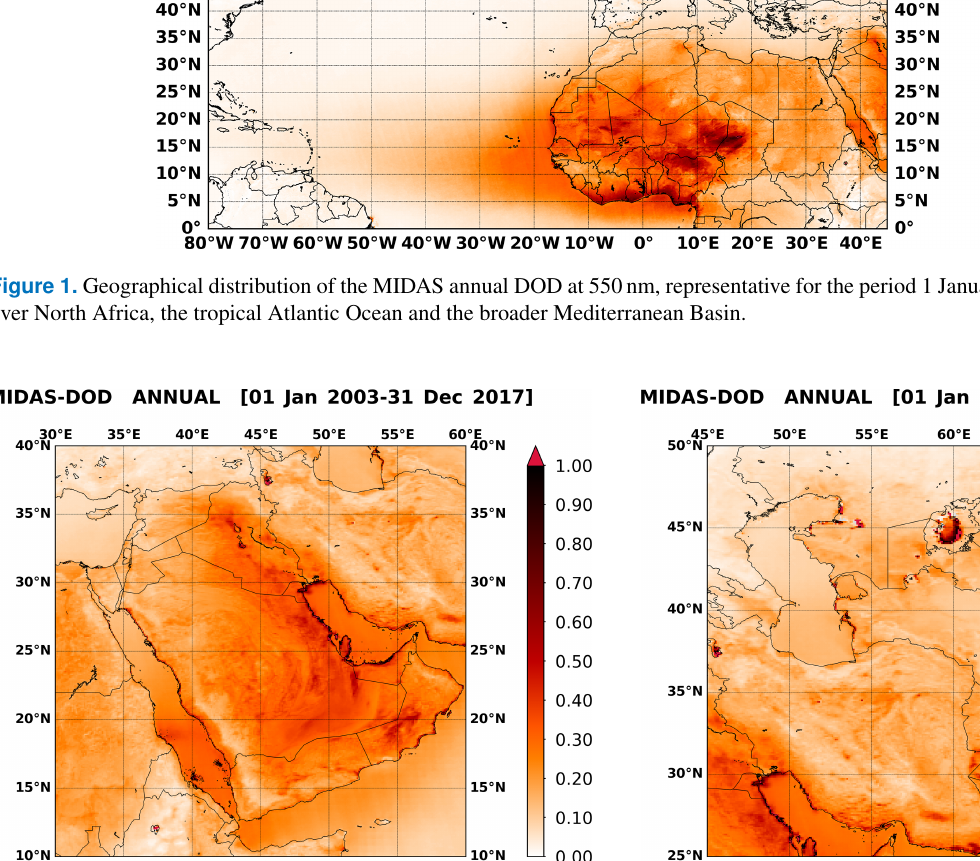
averaging over each grid cell using the standard error; i.e.,